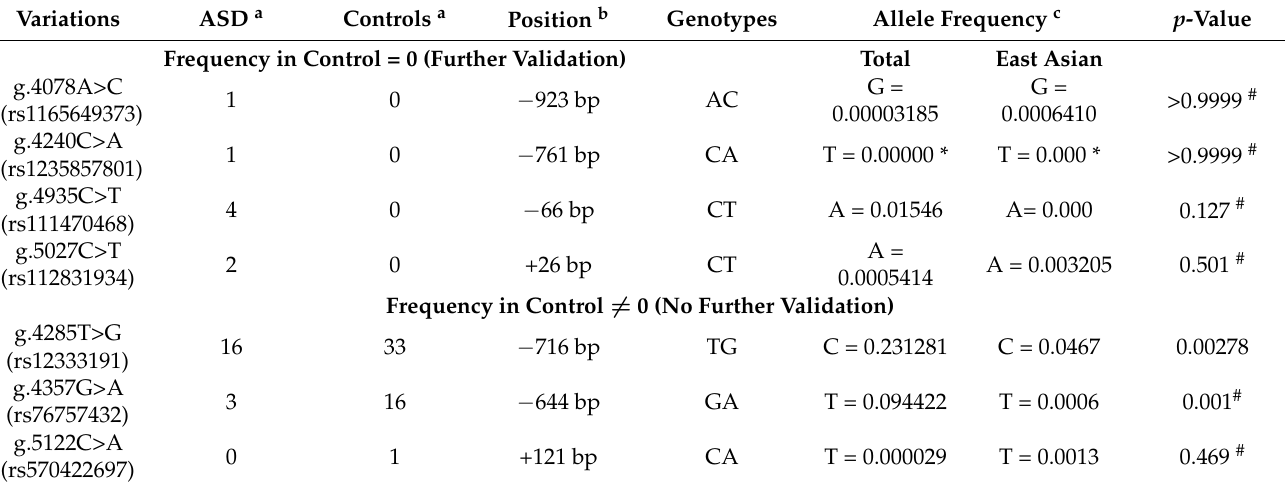
Table 2. Variants found in the CITED2 gene promoter region in patients with atrial septal defect in comparison with healthy